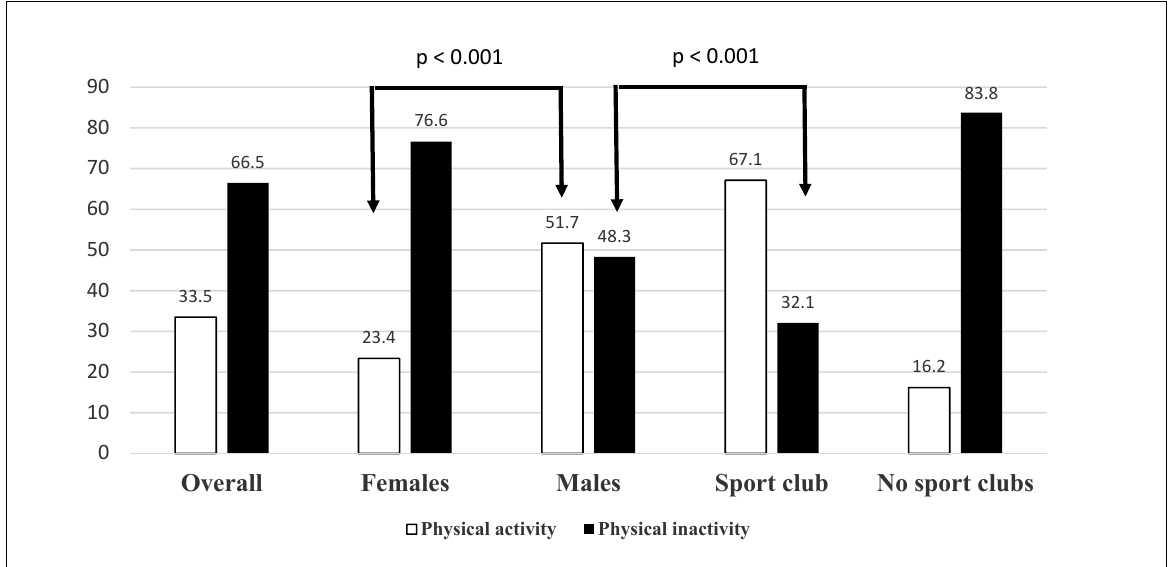
Figure 1. Physical activity differences between different groups in percentages Note . Significant differences were found in physical activity between males and females ( p = .001) and participation to sport club activities ( p =